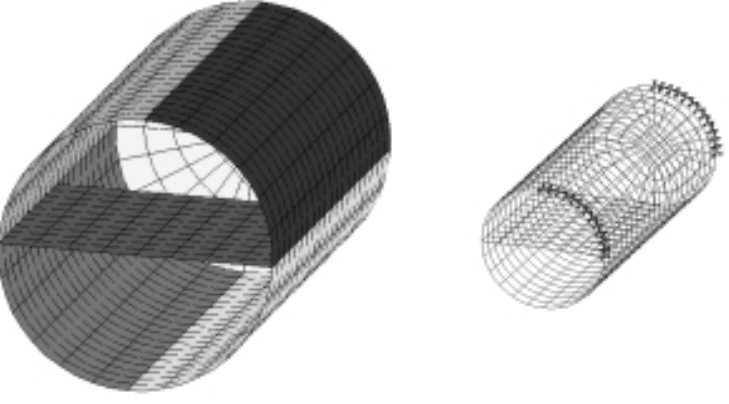
Fig. 1. Cylinder with end-cap and floor panel substructured into six substructures (left) boundary conditions